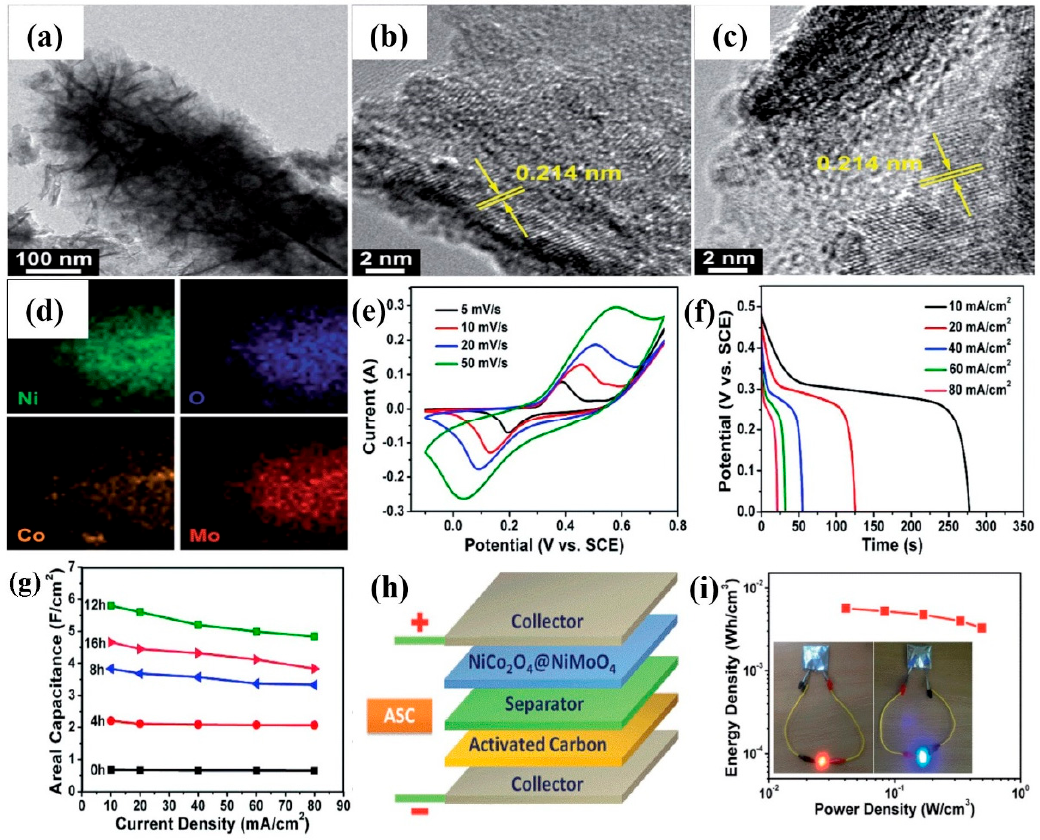
Figure 4. ( a ) TEM image of NiCo 2 O 4 − NiMoO 4 (4 h) core − shell hybrid nanostructure, ( b , c ) HRTEM images corresponding to the shell region, ( d ) EDS mapping images, ( e ) CV curves of NiCo 2 O 4 − Ni- MoO 4 NWSAs (12 h) at different scan rates, ( f ) Discharge curves of NiCo 2 O 4 − NiMoO 4 NWSAs (12 h) at various current densities, ( g ) Areal capacitance of the electrode with respect to current density, ( h ) Schematic illustration of the assembled ASC device, ( i ) Ragone plot of the device, inset shows the red and blue LEDs lit up by two assembled ASC devices joined in series [72]. Reproduced from Ref. [72] with permission from The Royal Society of Chemistry,